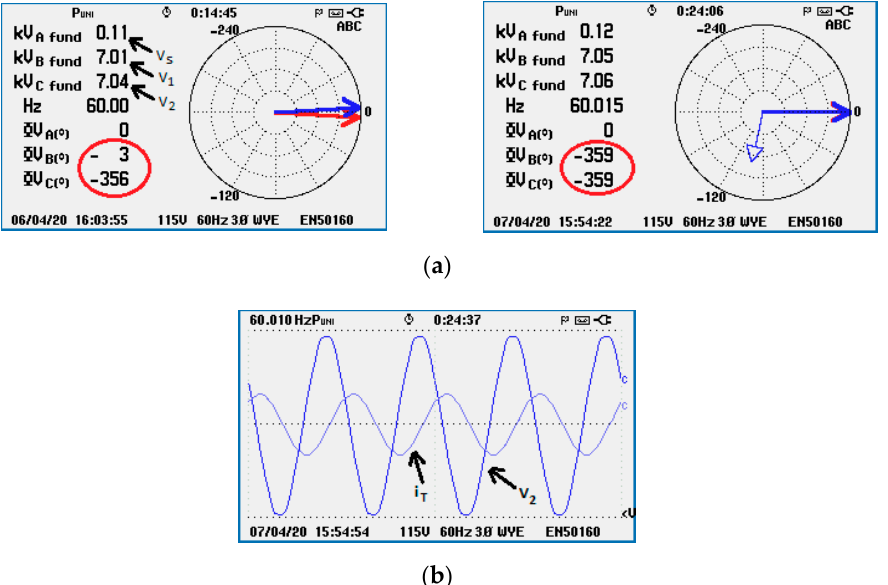
Figure 20. With and without converter operation voltage analysis; ( a ) C 1 insertion stage–without the converter operation; ( b ) C 1 insertion stage–with converter operation.